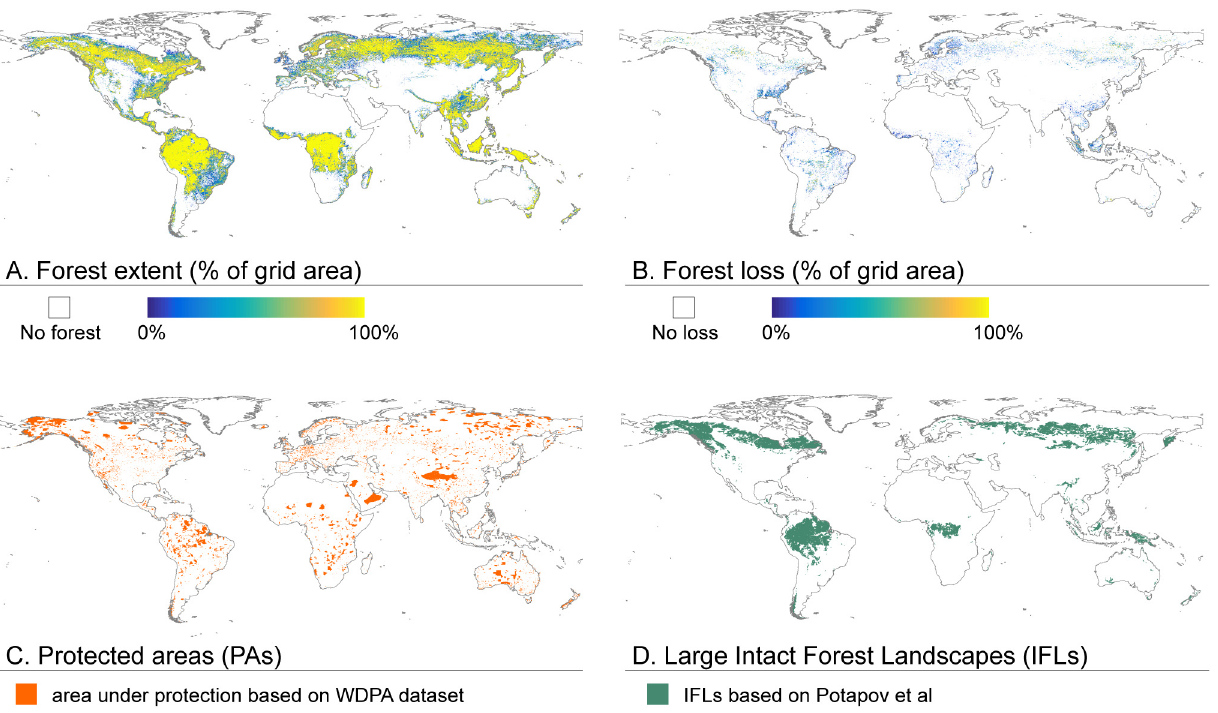
Fig 1. Aggregated (A-B) and converted (C-D) datasets used for the forest loss analyses. A) Forest extent in percentage of grid area at 1 km resolution, based on Global Forest Change (GFC) data [5]; B) Forest loss in percentage of grid area at 1 km resolution, based on GCF data [5]; C) Protected areas based on World Database of Protected Areas (WDPA) [30], converted to 1 km resolution; and D) Large Intact Forest Landscapes (IFLs) based on dataset by Potapov et al [20], converted to 1 km resolution.